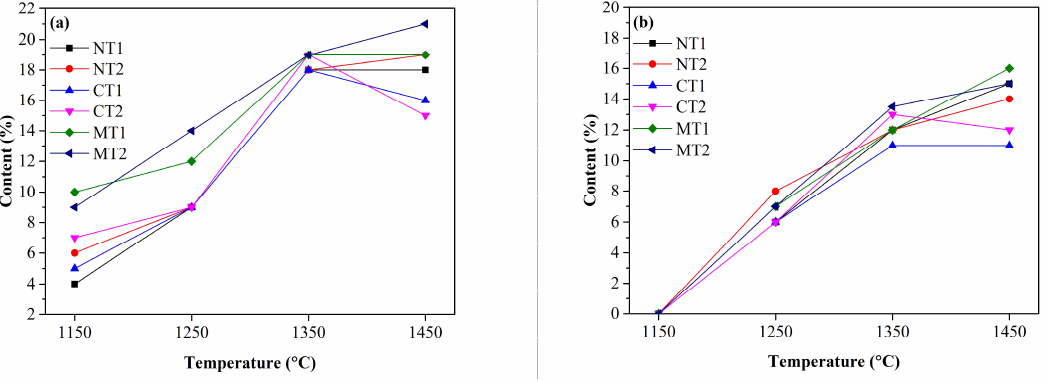
Figure 3. Spinel ( a ) and CA 6 ( b ) contents in alumina-magnesia refractory castables containing Ti-bearing compounds as a function of the calcination